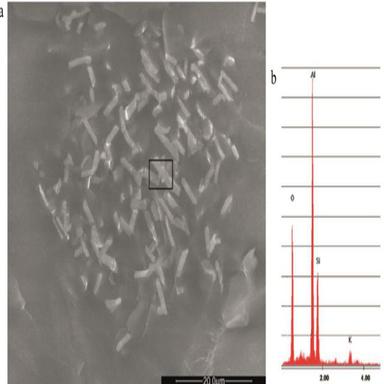
(a) Scanning electron microscope (SEM) observation of mullite crystals obtained after firing of kaolinitic clay at 1400 C; (b) EDS analysis of the obtained mullite crystals on the square-marked area.